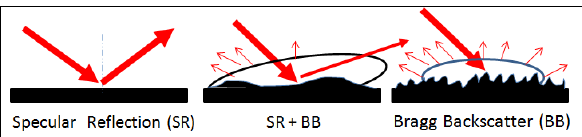
Figure 2. The surface scattering types